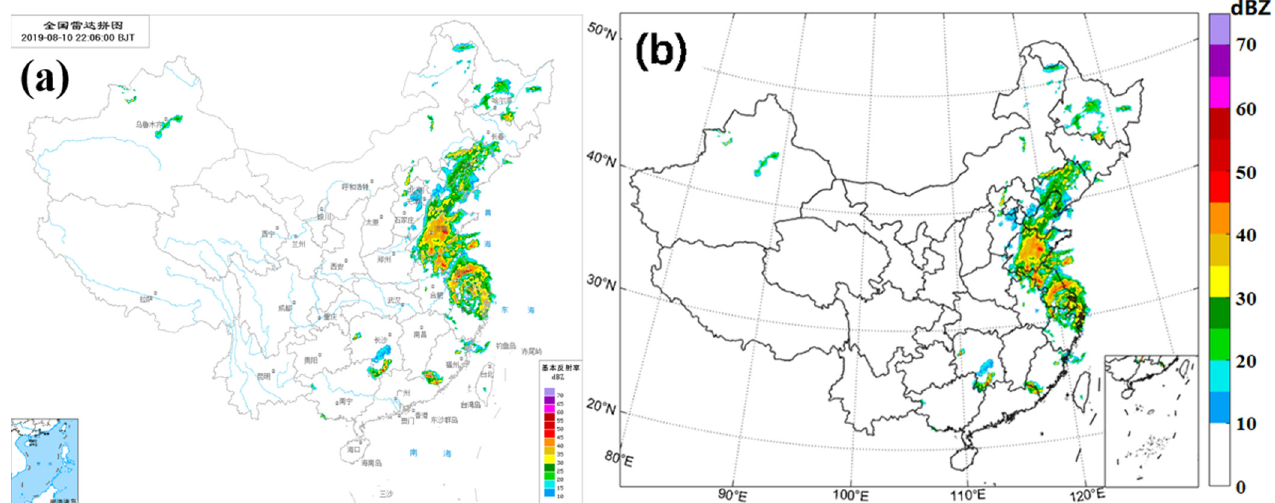
Figure 2. Radar data. ( a ) Radar reflectivity mosaic image with geographic annotations (in Chinese). ( b ) Radar reflectivity mosaic image after background processing and re-projection.